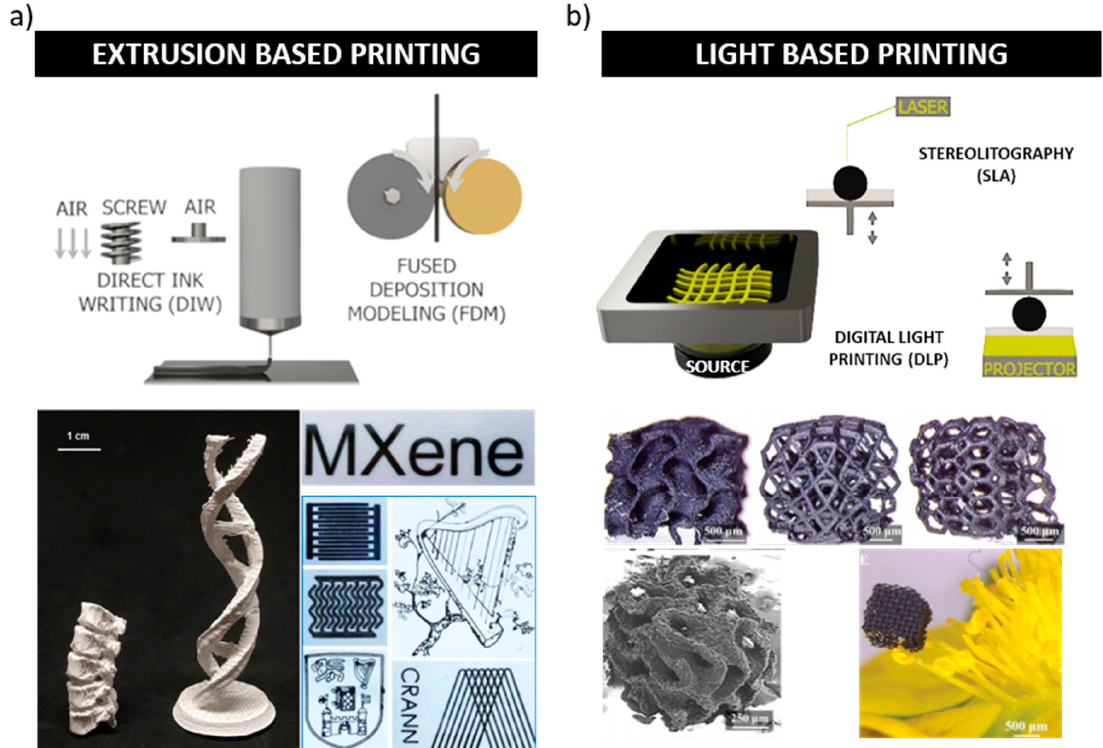
Figure 2. 3D printing methods used for 2D materials. ( a ) Extrusion-based printing shows the two methods described below, DIW, where the ink is impulse by different inputs (air, screw, or piston), and FDM, where a filament melted by temperature is deposited in the plate. Moreover, two examples are shown: hexagonal boron nitride dispersed in poly (lactic-co-glycolic acid) and printed by DIW (bottom left) and titanium carbide (Ti 3 C 2 Tx) MXene inks, dispersed in water in the absence of any additive for extrusion printing. (bottom right). Reprinted with permission from ref. [73] and ref. [75]. Copyright Light based printing shows the methods described below, DLP where the light is made by projection and each slide of the structure, and it is photo-polymerized at the bottom of the platform and SLA where a laser source beam point-by-point on the top of the ink and forms the 3D structure. Figure adapted and reprinted with permission from ref. [80]. Copyright 2018 RSC and under Creative Commons Attribution-Noncommercial.